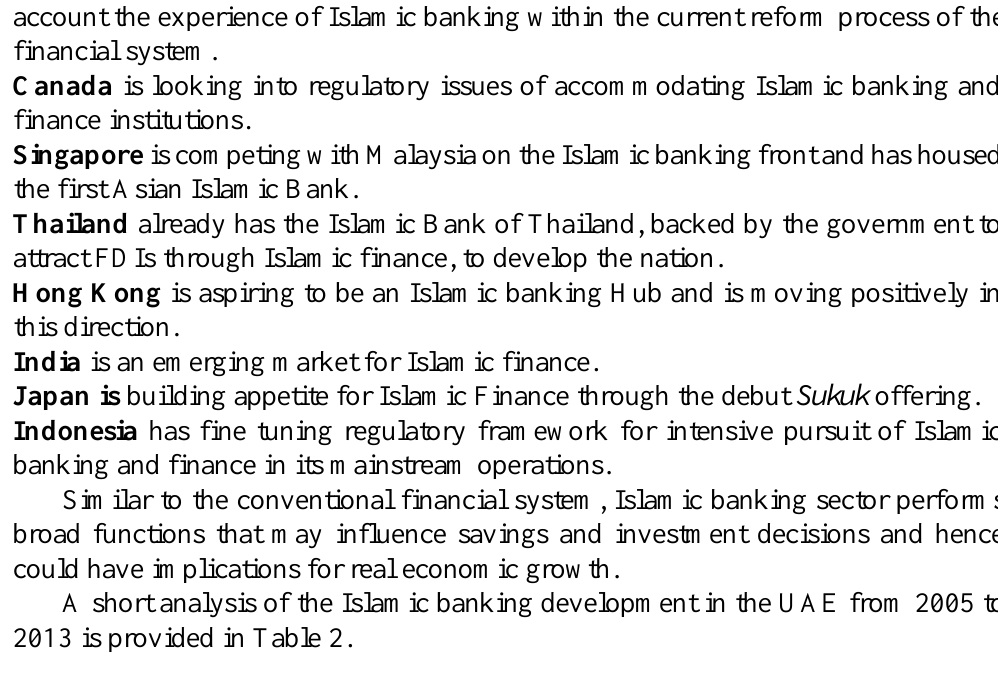
Table 2. Islamic banking in UAE: 2013, thousands US Dollar, USD, ( The World Bank ,